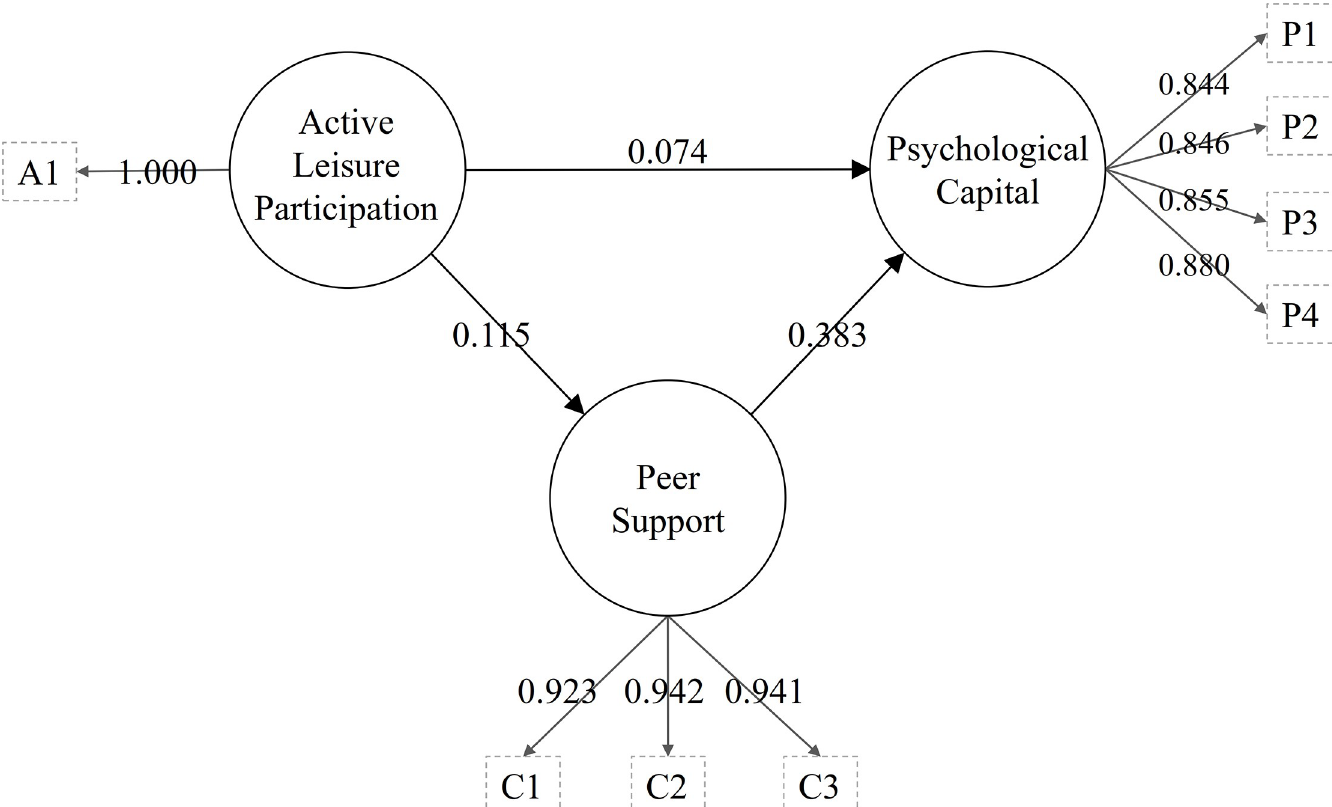
Fig 2. The analysis of PLS-SEM among active leisure participation, classmate support, and psychological capital.